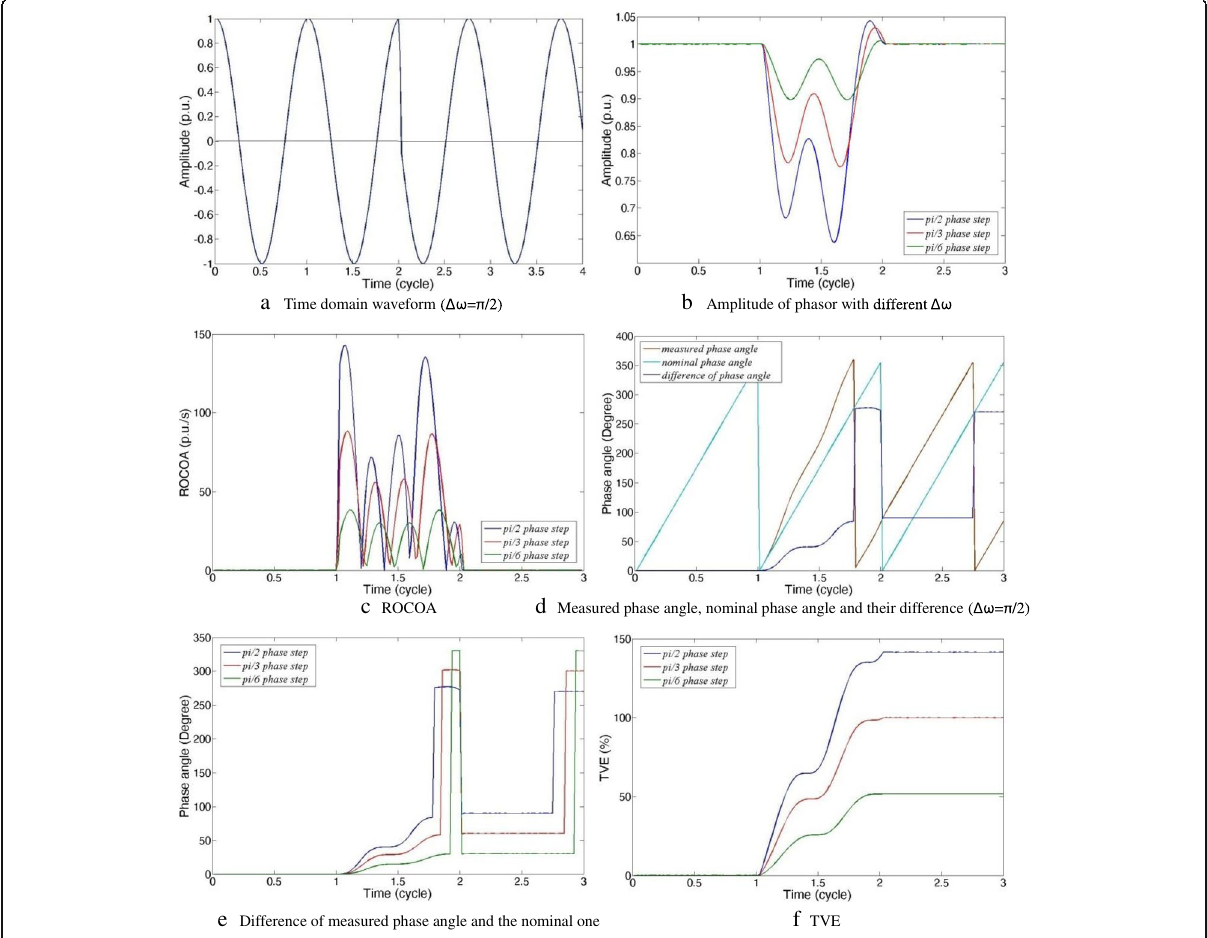
Fig. 7 Phase step change examples (step change occurs at the beginning of the second cycle t = 2 T , A = 1 p.u., f 0 = 60 Hz, φ 0 =